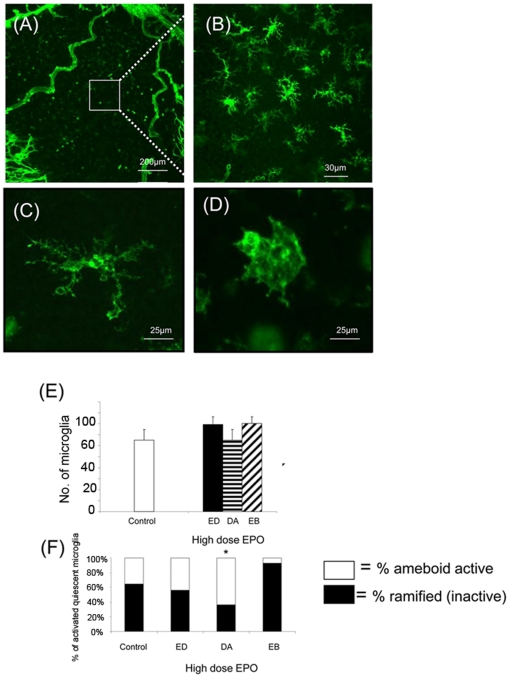
Alterations in activity of microglia in ischaemic area of the retinas of P17 ESA treated mice.Microglia were assessed in the ischaemic area of the retina (A and B) and divided into two groups – ramified (C) and ameboid (D). The activity of the microglia in the retina was assessed in the high dose of epoetin delta, darbepoetin alfa and epoetin beta. (E) There was no overall alteration in the number of microglia with Epoetin Delta (ED), Darbepoetin Alfa (DA) or Epoetin Beta (EB) administered relative to the control (n = 5 retinas assessed, four ischaemic areas per retina). In (F) The high dose of Darbepoetin Alfa increased the number of ramified microglia relative to the control (p<.05) (Error bars  =  Standard Error of the Mean).